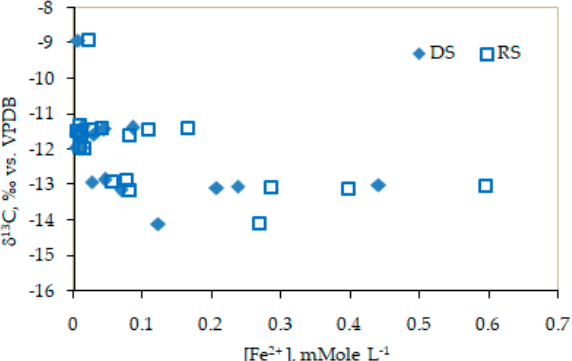
Figure 11. Scatter plot of δ 13 C vs. [Fe 2 + ] for water in Pleistocene, Neogene and Triassic aquifers in the study region.